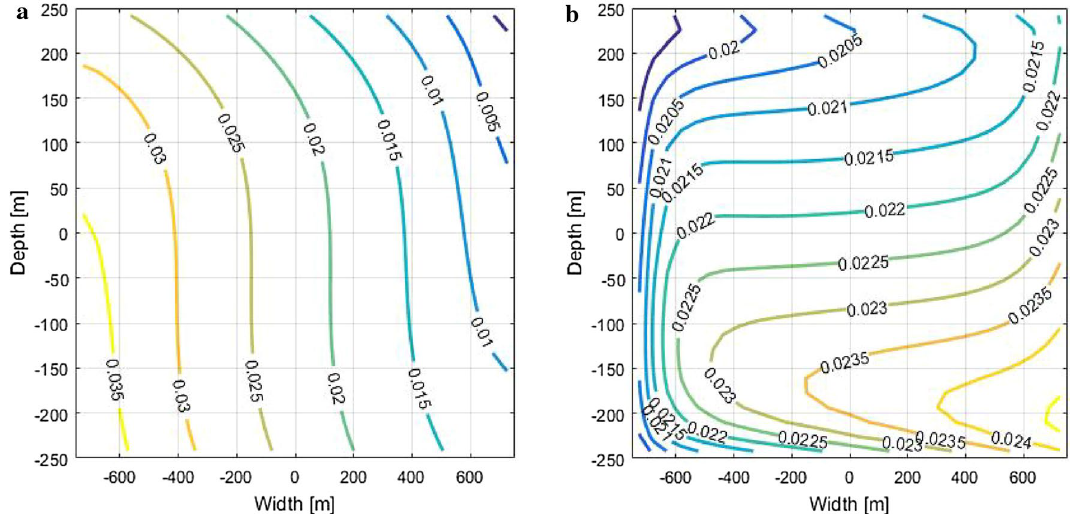
Fig. 7 a Contour plot of C 7+ composition, convection free. b Contour plot of C 7+ composition, with natural convection,